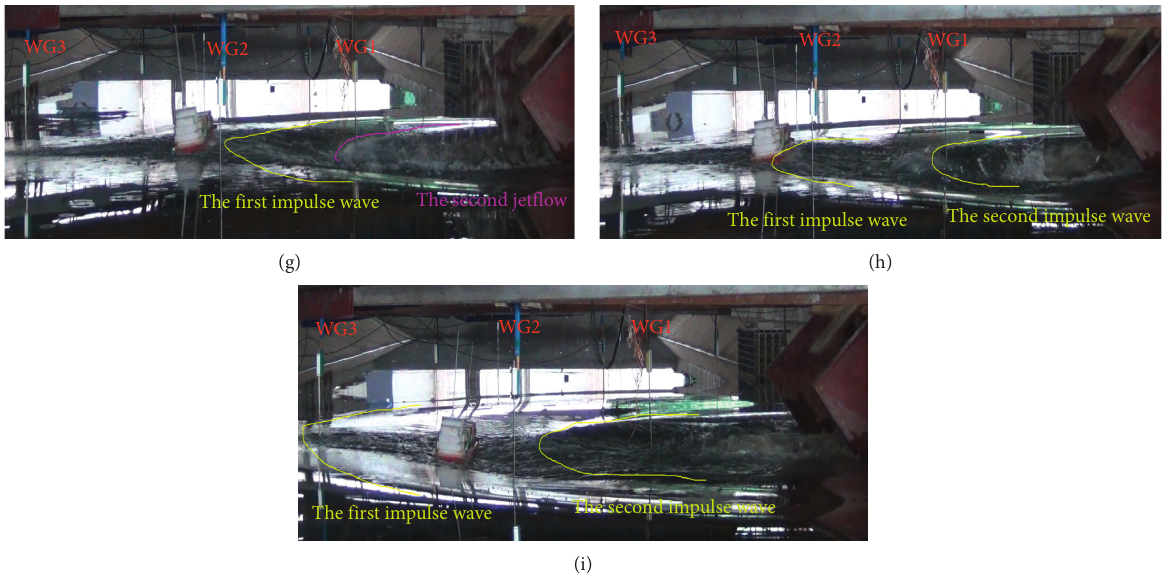
Figure 6: The process of waves generation from test no. 15 with l � 1.0m, w � 1.0m, s � 0.6 m, h � 0.74m, and α � 40